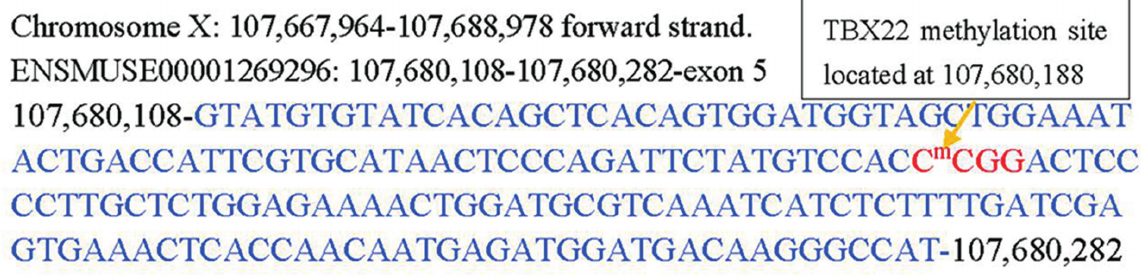
Figure 3 - Methylation site of TBX22 exon 5 is at a CpG site (http://asia.ensembl.org/Mus_musculus/Transcript/Exons?db=core;g =ENSMUSG00000031241;r=X:107667964-107688978;t=ENSMUST00000118986).